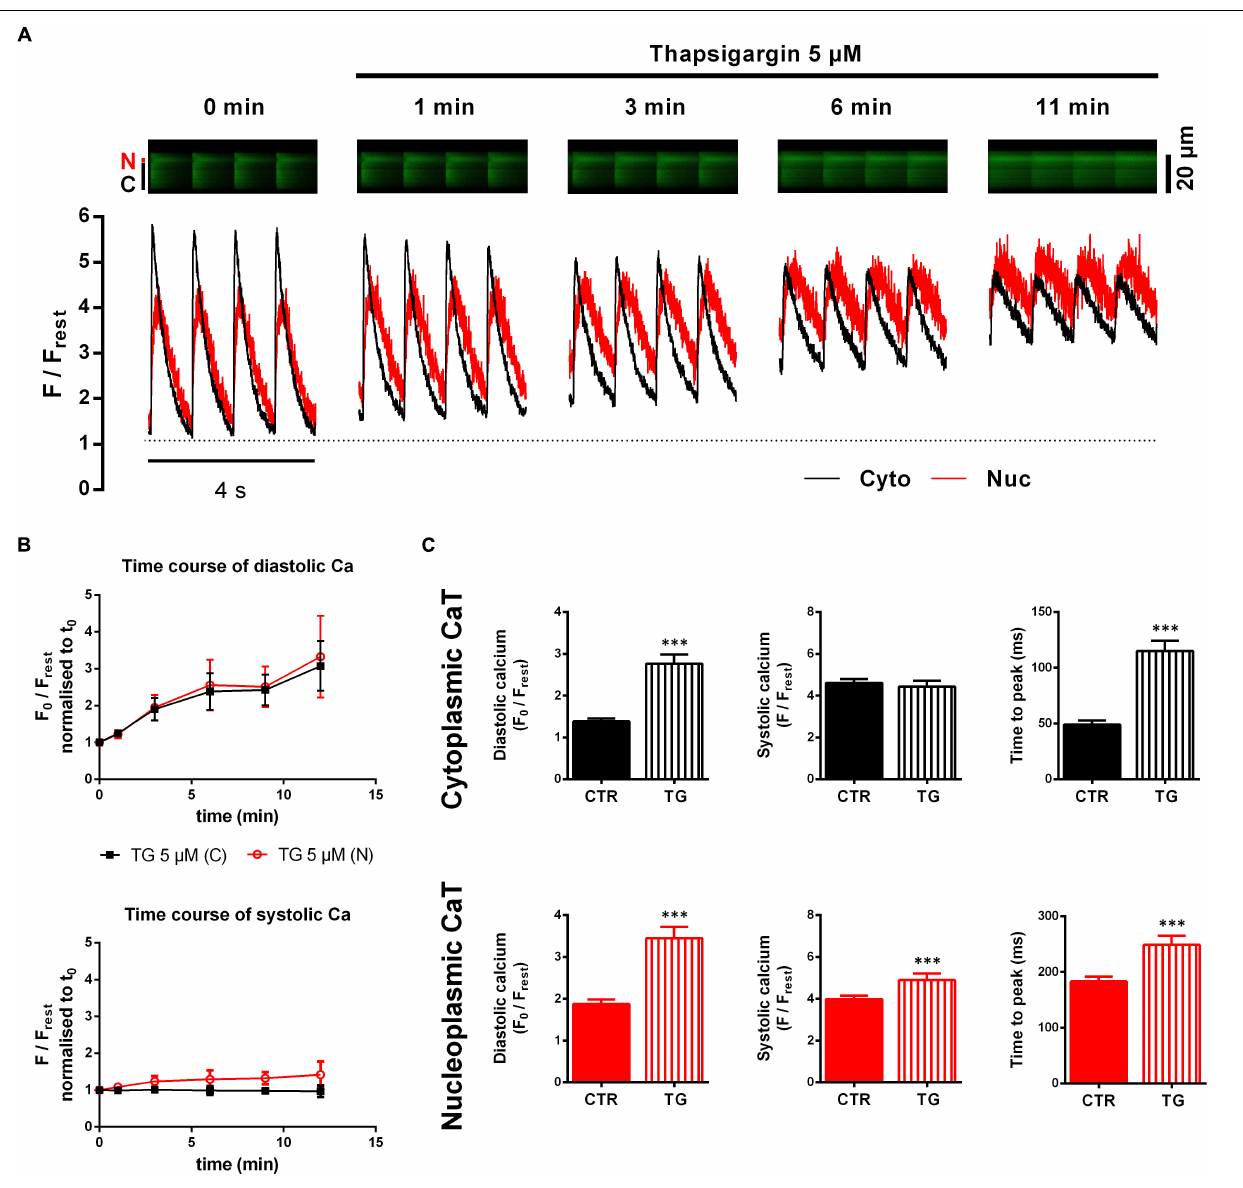
FIGURE 3 | Cyto- and nucleoplasmic CaTs during SERCA inhibition by thapsigargin (TG). (A) Line-scan recordings of electrically stimulated cytoplasmic (C, Cyto, black) and nucleoplasmic (N, Nuc, red) CaTs at different time points after TG application. Fluorescence images (upper panel) and corresponding traces (lower panel) show a time-dependent increase in baseline fluorescence (=diastolic Ca) and slowing of decay kinetics. (B) Pilot experiments to study the time course of the TG effect ( n / N = 5/1). Mean values of diastolic Ca (upper panel) normalized to t 0 show a constant increase over time, whereas systolic Ca (lower panel) only increases in the nucleus. (C) Comparison of average CaT characteristics for the cyto- and nucleoplasm in the absence and presence of TG. ∗∗∗ P < 0.001 vs CTR, n / N = 39/13.